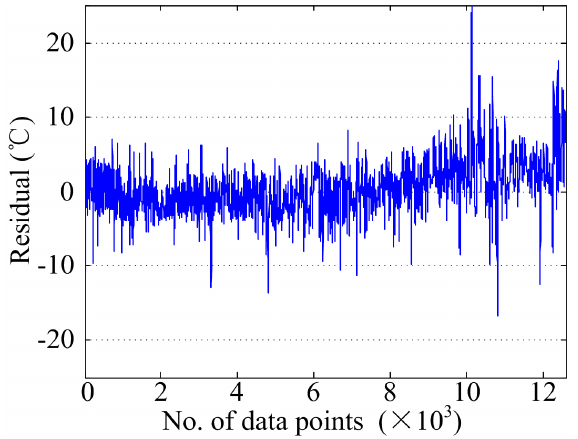
Figure 10. Residual of model for the temperature of generator bearing B in WT 17.